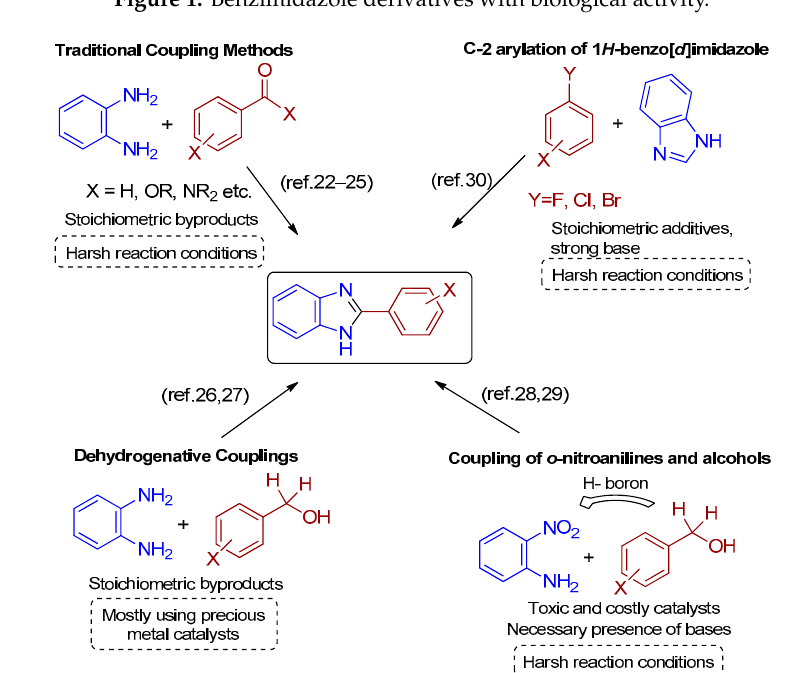
Scheme 1. Strategies toward the synthesis of 2-aryl-benzimidazoles.